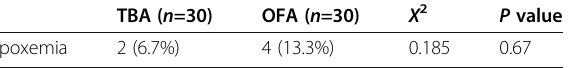
Table 5 Comparison between groups as regards postoperative hypoxemia